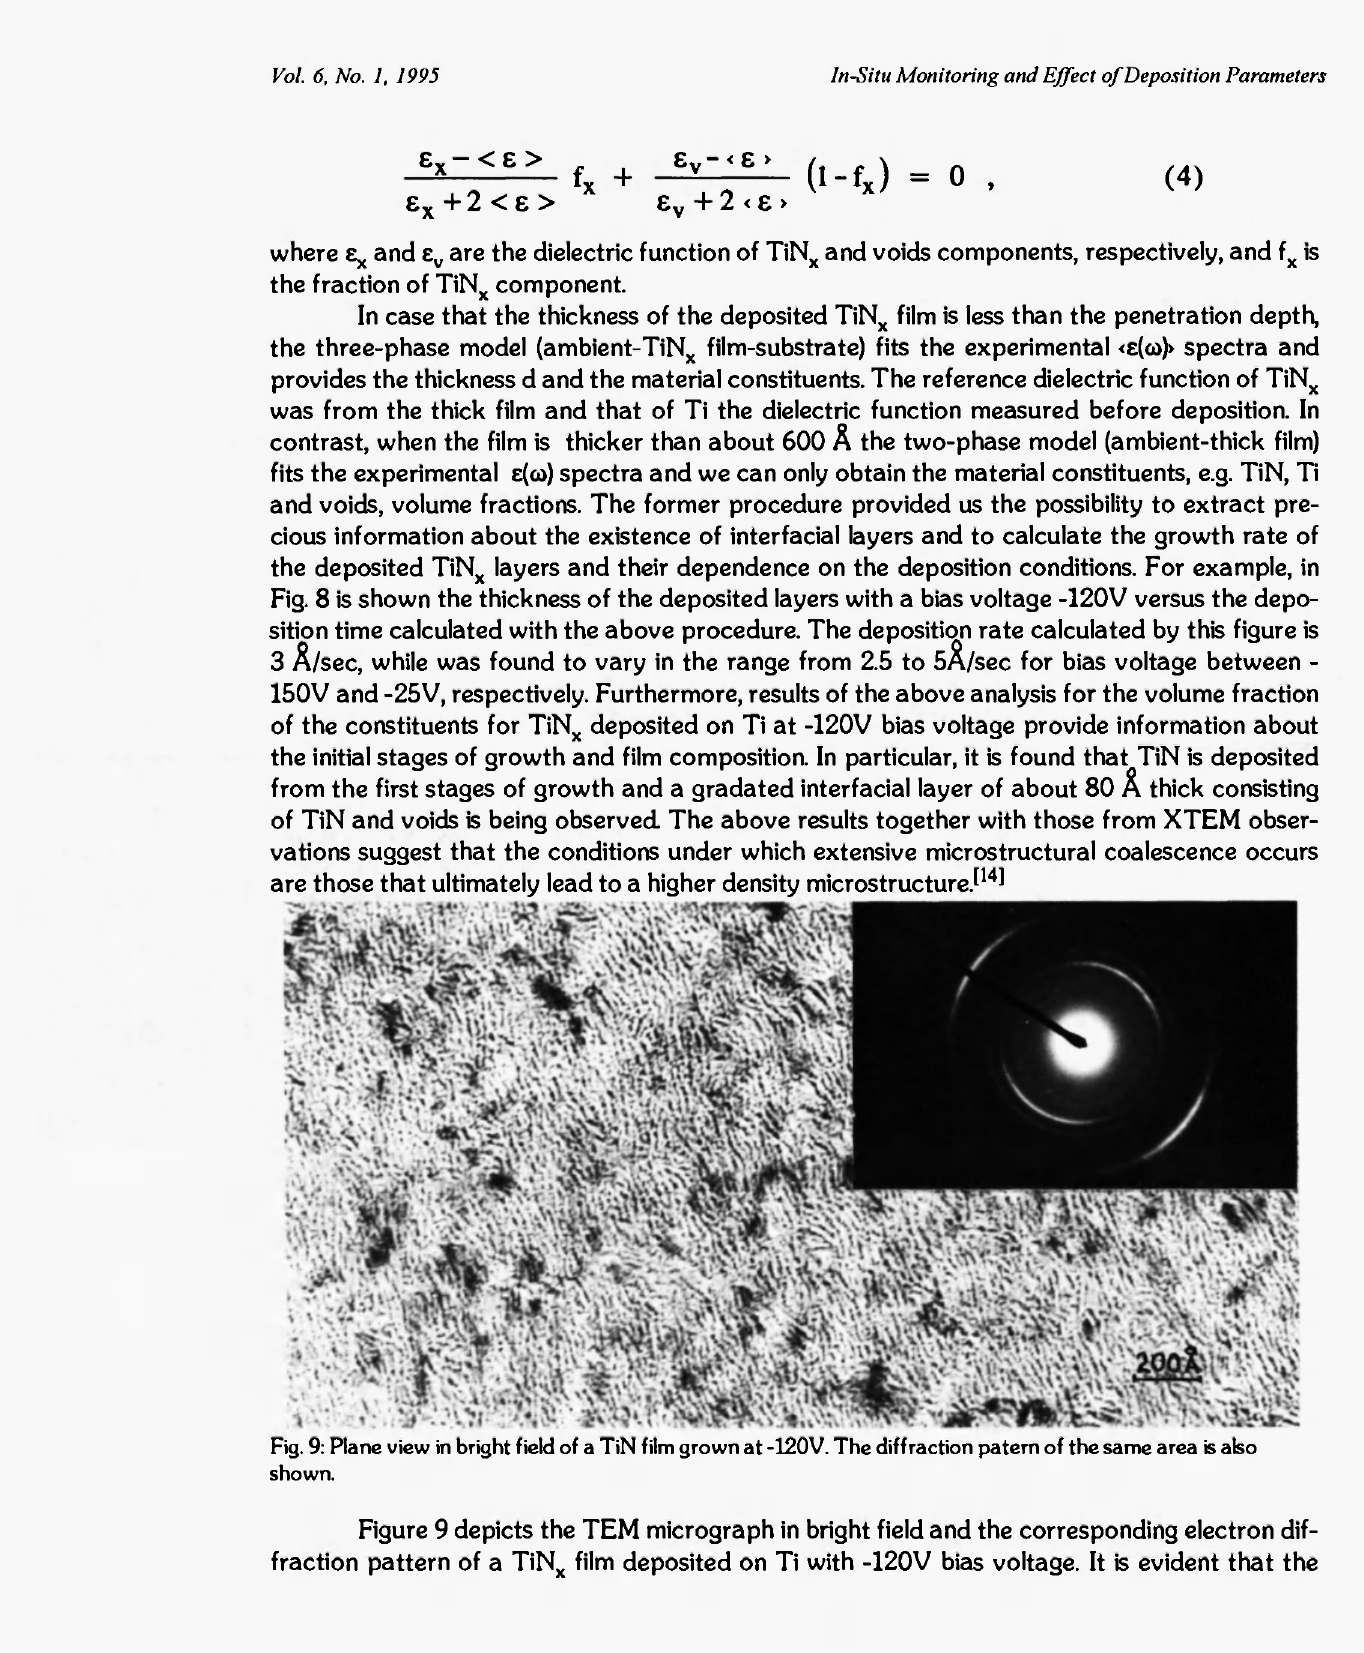
Fig. 9: Plane view in bright field of a TiN film grown at -120V. The diffraction patern of the same area is also